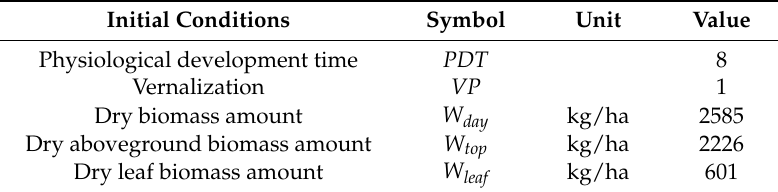
Table 2. Initial conditions of winter wheat.